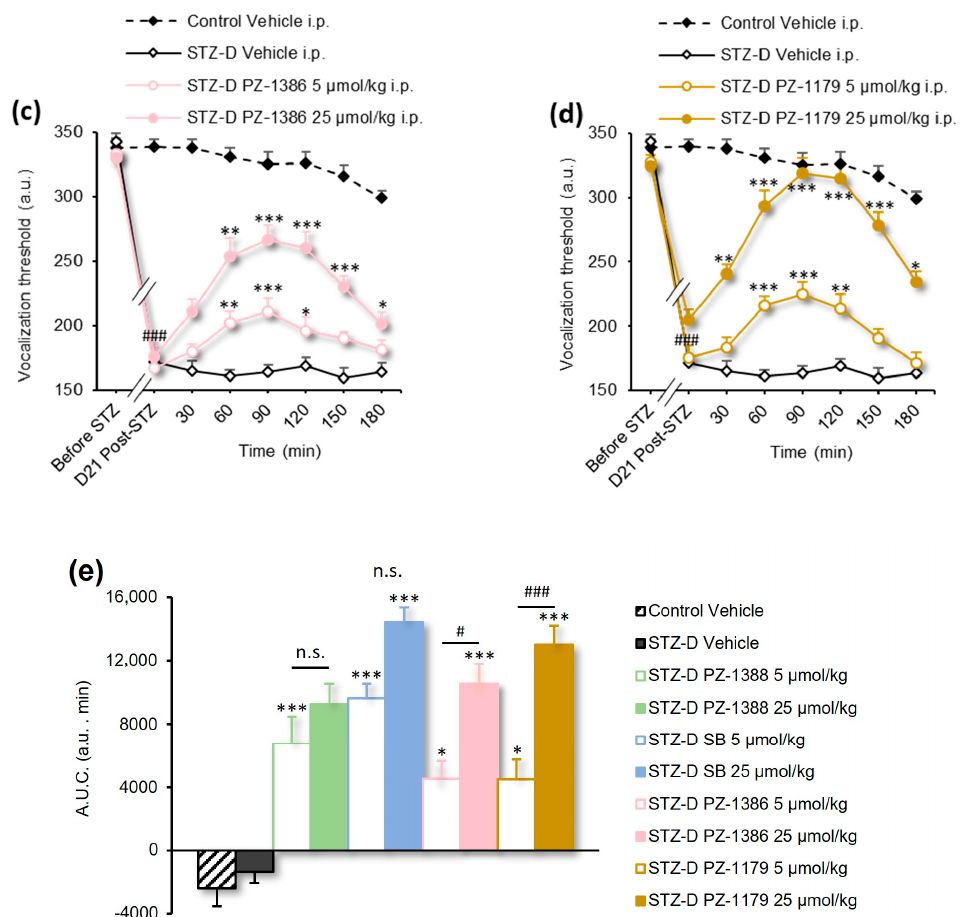
Figure 1. Systemic administration of 5-HT 6 receptor inverse agonists reduces diabetic neuropathic pain (paw pressure test). ( a ) Intraperitoneal administration of PZ-1388, ( b ) SB258585, ( c ) PZ-1386, and ( d ) PZ-1179 (5 and 25 µ mol/kg each) but not the vehicle (water for injections) improves mechanical hy- peralgesia to paw pressure in STZ diabetic (STZ-D) rats ( n = 11–15/group). Vocalization thresholds are expressed as arbitrary units (a.u.). ### p < 0.001 vs. values measured before STZ; * p < 0.05, ** p < 0.01, *** p < 0.001 vs. values measured before the drug/vehicle (water) injection (D21 Post-STZ), 2-way ANOVA. ( e ) Area under the curve (A.U.C.) of vocalization threshold variations in STZ-D and control rats calculated by the trapezoidal rule (in a.u.. min). * p < 0.05, ** p < 0.01, *** p < 0.001, vs. STZ-D Vehicle group; # p < 0.05 ### p < 0.001 vs. corresponding group, 1-way ANOVA.